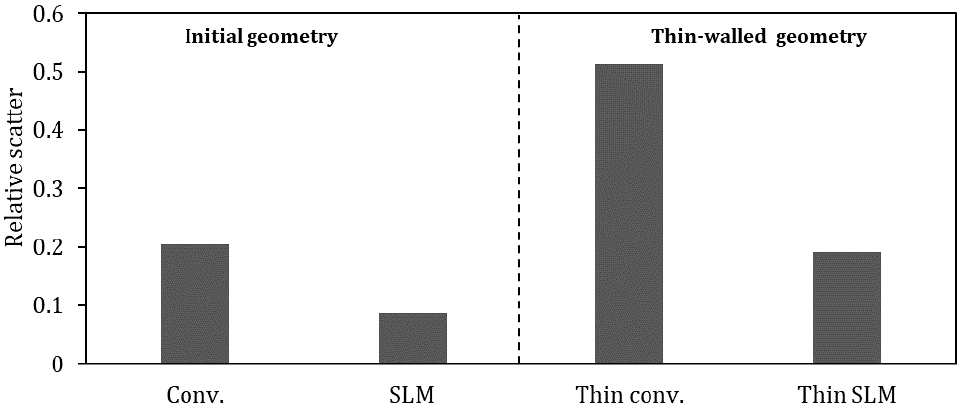
Figure 15. Relative scatter for the different test series.